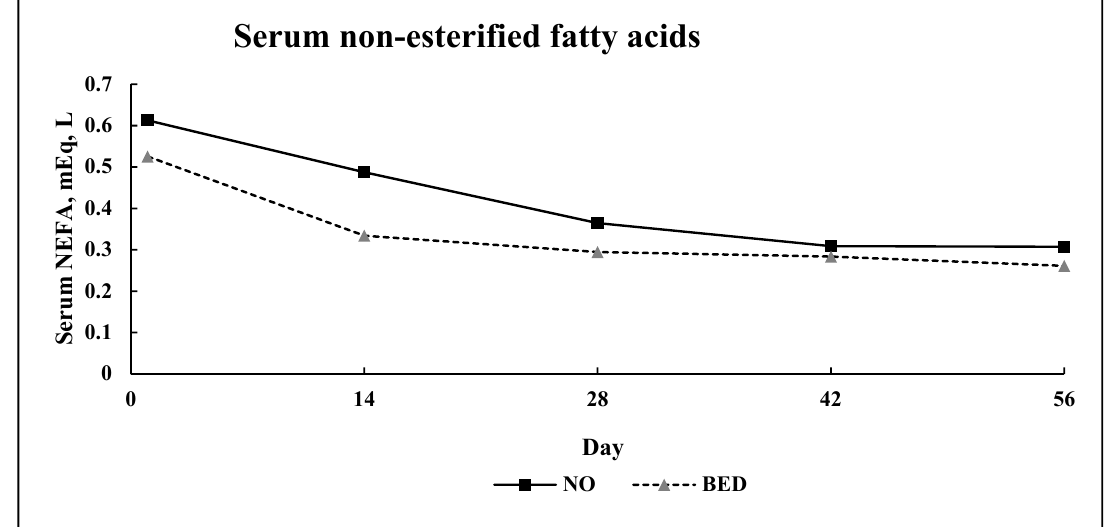
Figure 6. Experiment 2: Serum concentration of non-esterified fatty acids (NEFA) in finishing steers ( n = 9 pens/treatment; pooled bed × day SEM (Structural equation modeling) = 0.038). Treatments were: (1) no bedding (NO) or (2) 1.0 kg (as-is basis) of wheat straw bedding/steer· d − 1 (BED). Blood was collected and harvested as sera on days 1, 14, 28, 42, and 56.